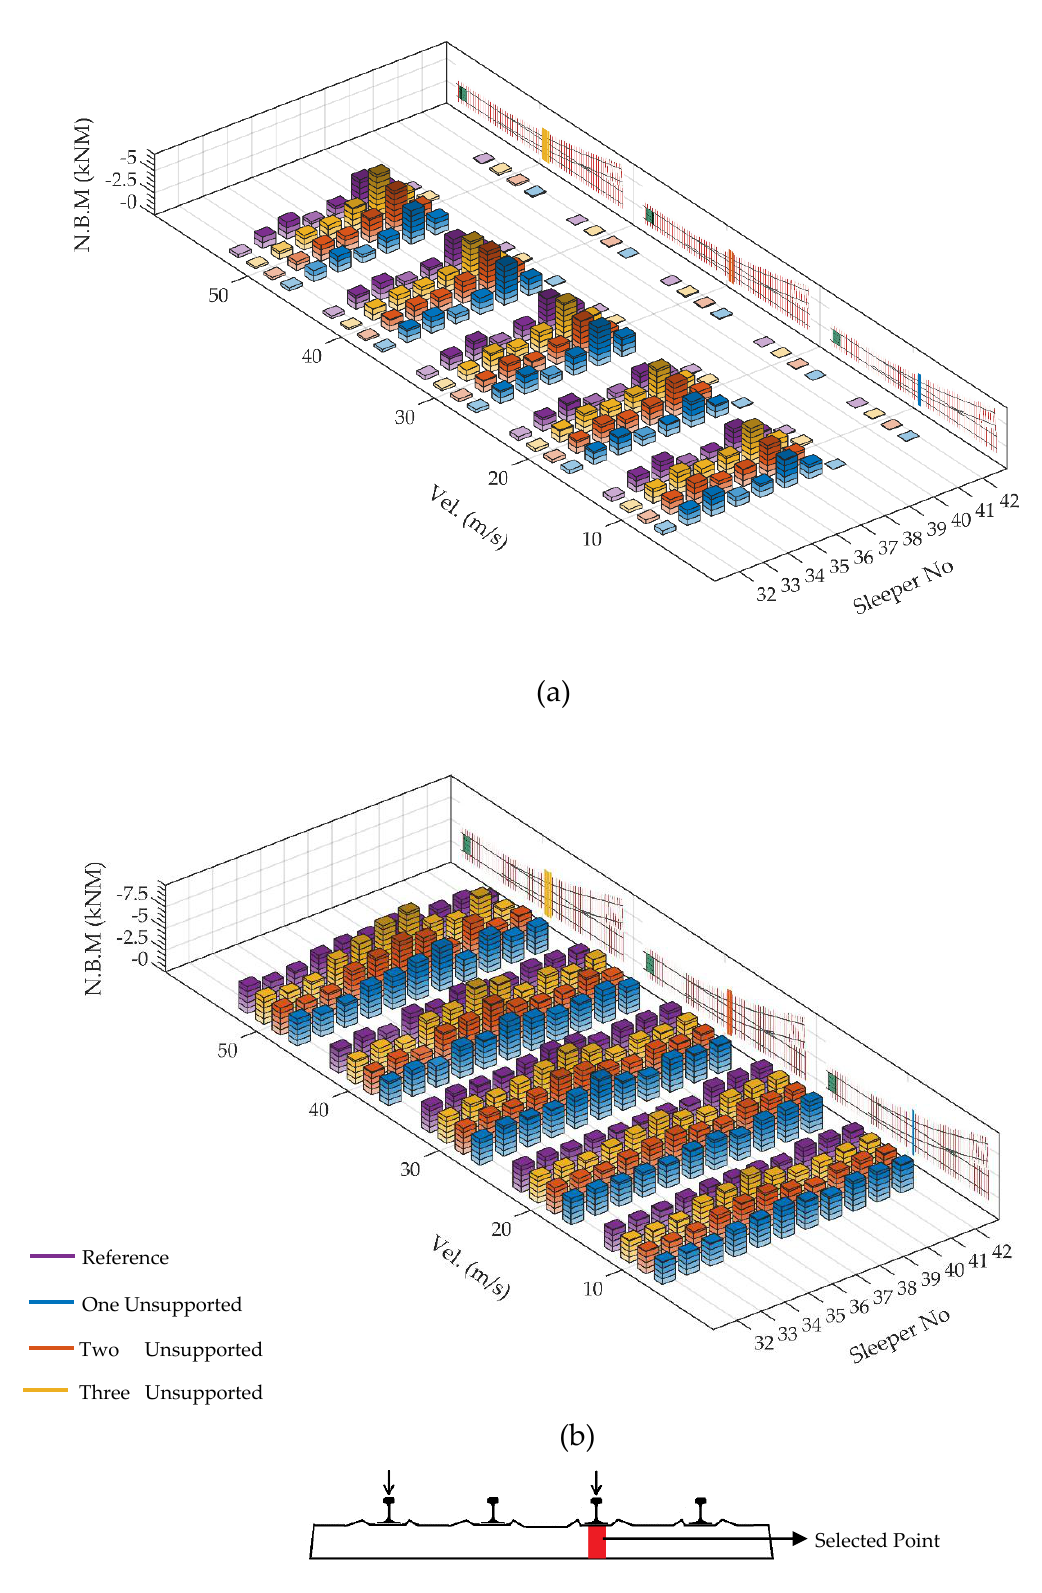
Figure 18. The distribution of negative bending moments over the bearers when unsupported bearers exist at closure panel: ( a ) at particular time when the front wheel is on the bearer with number 37; ( b ) when maximum occurs at each bearer.